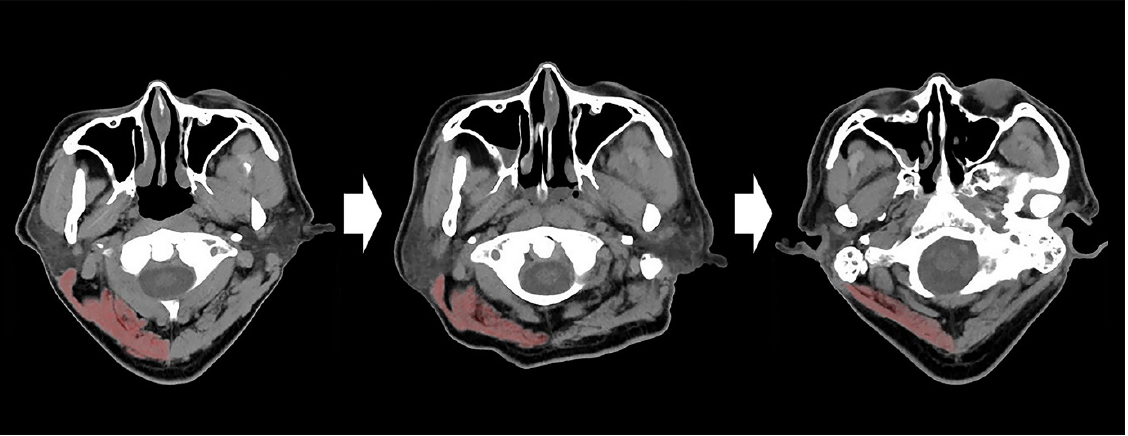
Figure 1. Serial changes of cervical muscle mass in a patient with traumatic brain injury. The brain CT images with 7 days intervals showed a progressive decrease of the cervical muscle mass. CT, computed tomography.